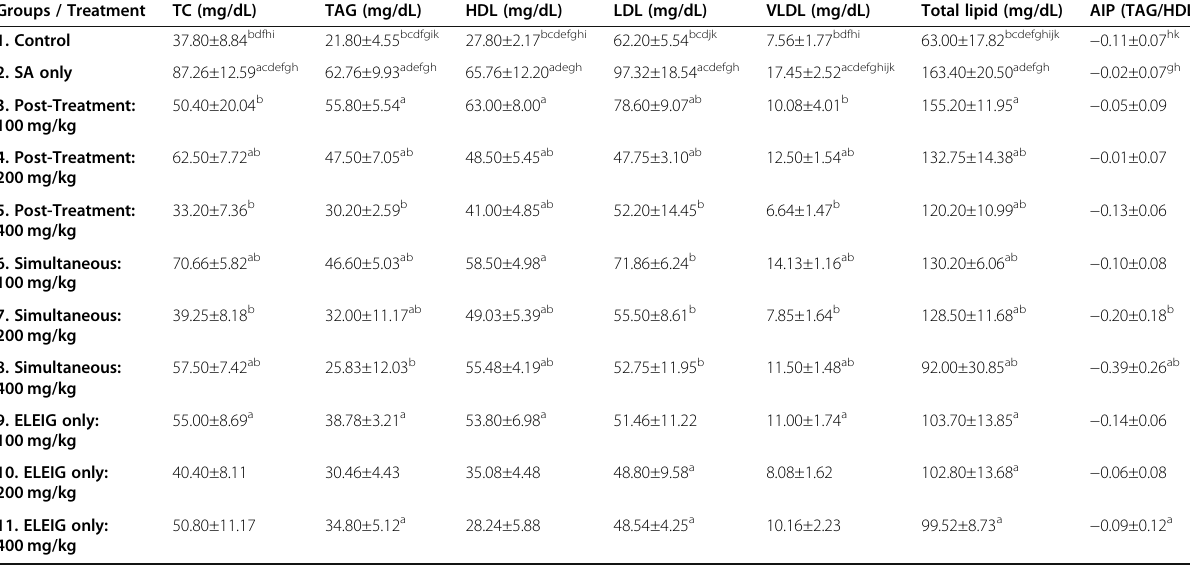
Table 2 Effect of ELEIG on Lipid Profile of Experimental Rats Groups / Treatment